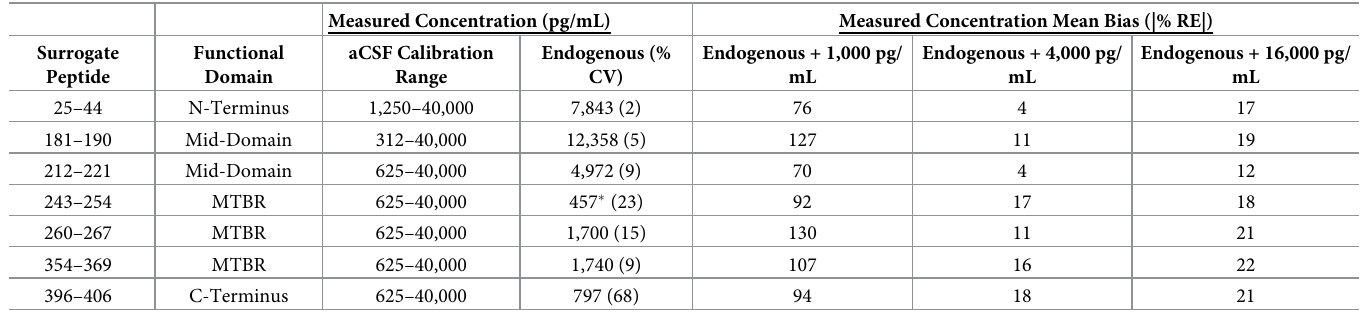
Reported values represent the inter-assay mean endogenous concentration, mean bias, and variance across the three analytical runs (n = 9